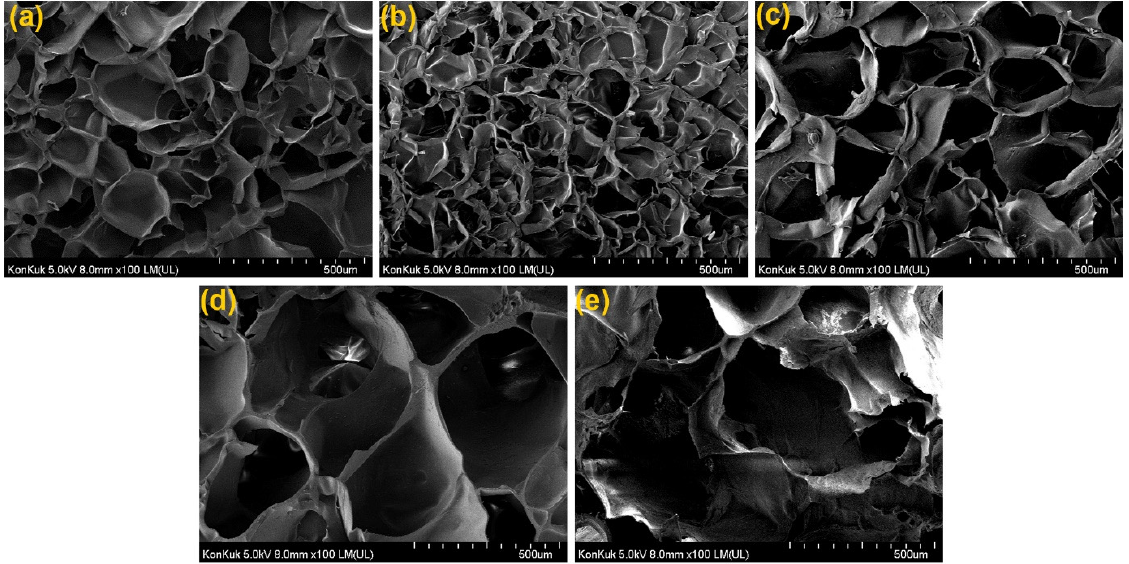
Figure 4. FE-SEM images of ( a ) P(NIPAM-AM), ( b ) OSG1/P(NIPAM-AM), ( c ) OSG2/P(NIPAM-AM), ( d ) OSG3/P(NIPAM-AM), and ( e ) OSG4/P(NIPAM-AM).